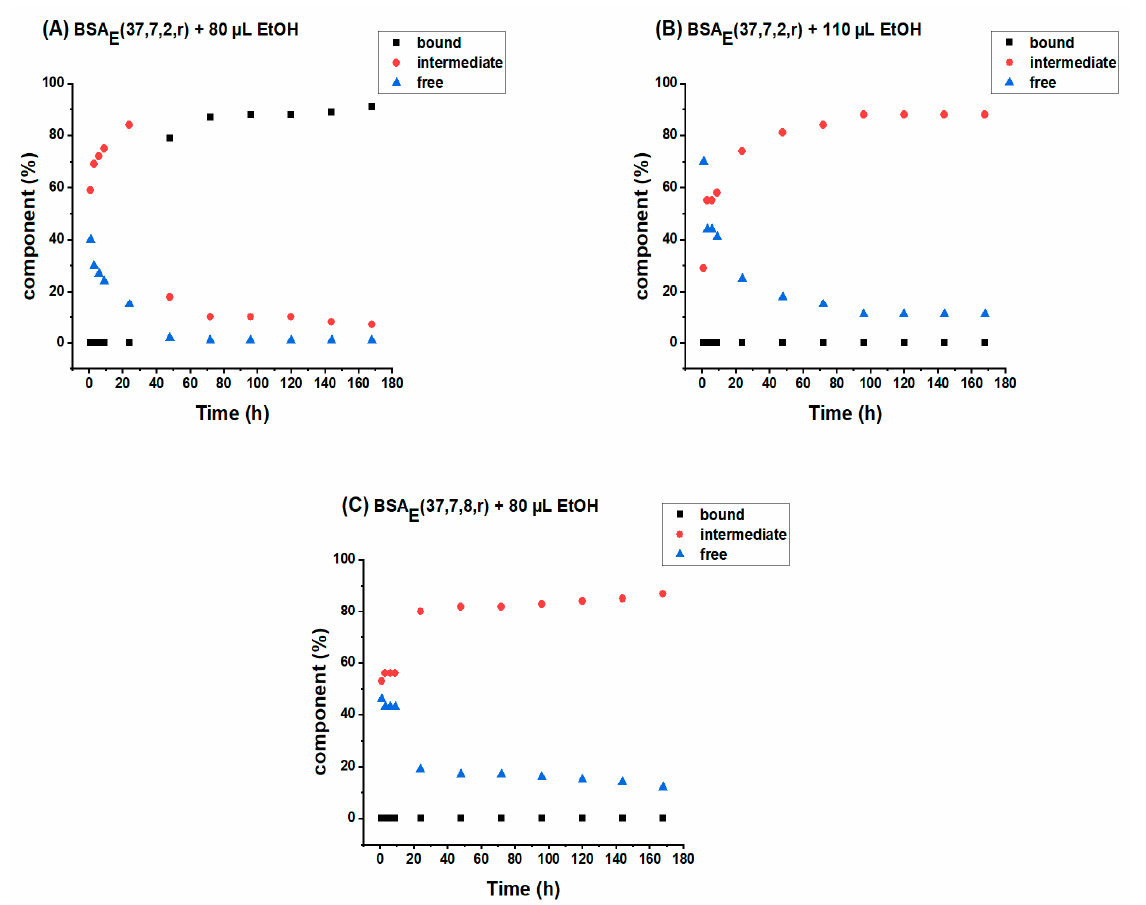
Figure 9. The released percentage of freely rotating SL-NPX, intermediately and tightly bound SL-NPX to BSA versus time intervals of ( A ) BSA E (37, 7, 2, r) with 80 µL ethanol, ( B ) BSA E (37, 7, 2, r) with 110 µL ethanol, and ( C ) BSA E (37, 7, 8, r) with 80 µL ethanol. In these samples, the molar ratio of SL-NPX:BSA is 1.2:1.